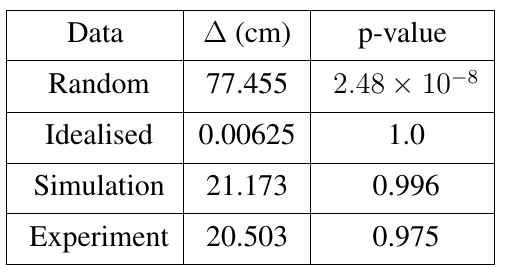
Table 1: Statistical check results